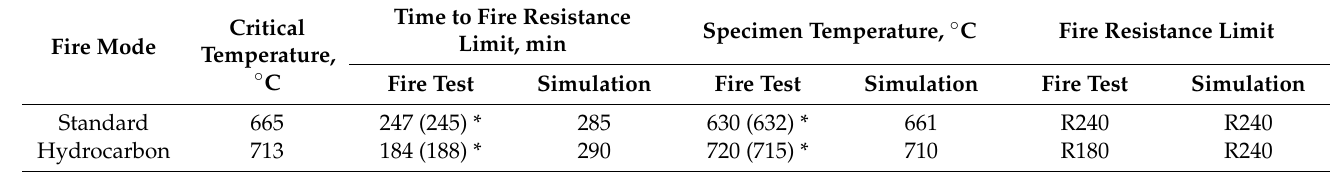
Table 6. Comparison between the results of experimental research and the steel column simulation.